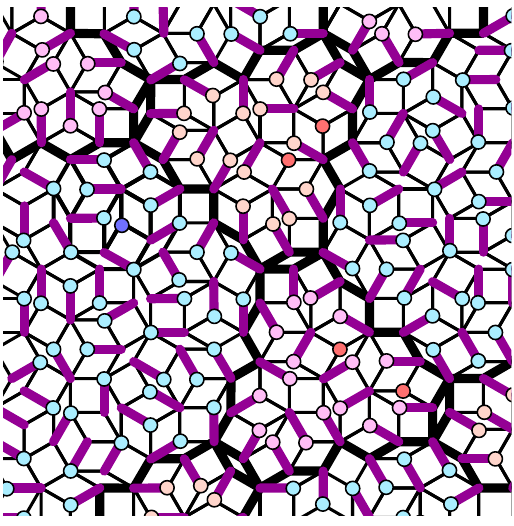
FIG. 17. A maximum matching of the Socolar-Taylor tiling [56,93]. Purple edges indicate dimers; the dark blue (four dark red) vertices indicate monomers, while light blue (light red) vertices connect to blue (red) monomers via alternating paths (note the two distinct colors of light red, indicating distinct monomer regions; the separation of the different blue regions is clear). Monomer membranes are identified with thick black lines. identify in 12 A contain a net imbalance of charge, as in the Penrose tiling, cases 12 B and 12 C additionally feature perfectly matched islands enclosed by membranes. A maxi- mum matching of a region of 12 B is shown in Fig. 18.